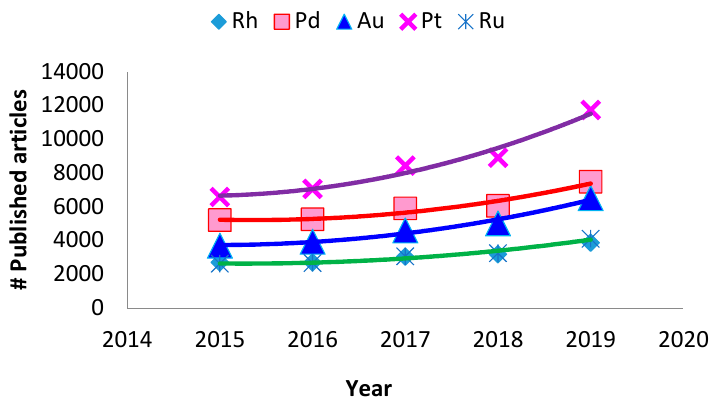
Figure 1. Number of published papers in the last 5 years, search directed on science direct page (www.sciencedirect.com) using combinations of simple keywords relating to corresponding metals (Pt, Pd, Ru, Rh or Au) and catalysts.